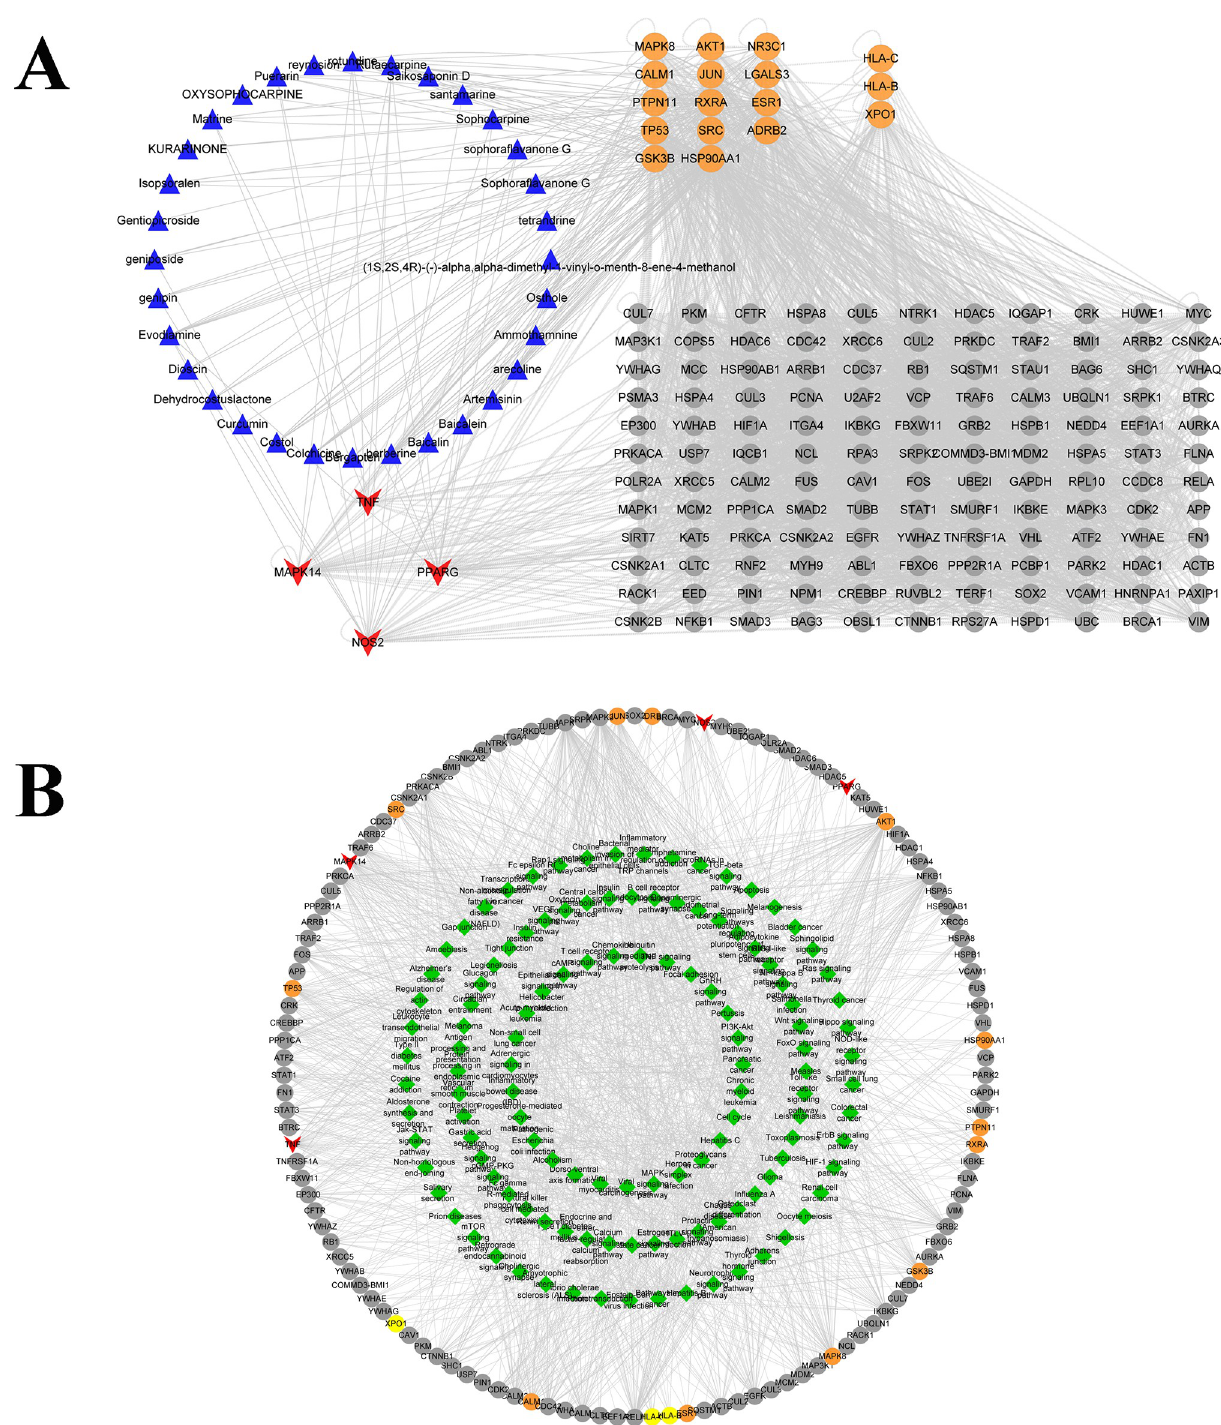
Fig 2. Component-target interaction network and target-pathway network. Note: (A.) The potential liver injury components urate-lowering Chinese medicine are indicated by blue triangles, the core targets are indicated by red arrows; the direct targets of components and “liver injury” are represented by yellow circles, and the interaction targets of components and “liver injury” are gray. (B.) The pathways are represented by green diamond. The targets are indicated by red arrow; the direct target of the compound and disease are represented by yellow circle, and the interacting proteins are represented by gray circle. To get an initial sense of the biological processes and pathways enriched by putative targets that were relative with liver injury, the functional enrichment analysis was conducted based on DAVID. And the results were classified into several signaling pathways, including pathways in cancer,